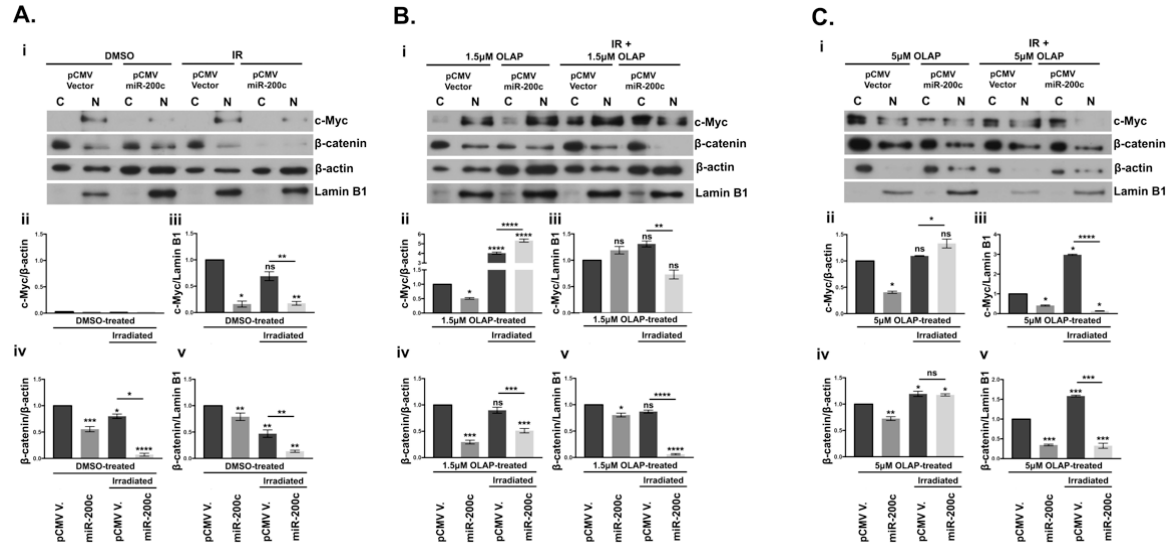
Figure 7. Effects of miR-200c on the distribution of c-Myc and β -catenin expressions in SKOV3 cell line. Cytoplasmic (C) and nuclear fractions (N) were analyzed by WB. β -actin and Lamin B1 are the housekeeping proteins used for cytoplasmic and nuclear extracts, respectively. ( A ) ( i ): empty vector (pCMV V.) and pCMV miR-200c SKOV3 cells treated with DMSO and 4 Gy irradiation (IR). ( B ) ( i ): vector and miR-200c transfected SKOV3 treated with 1.5 µM olaparib-only (OLAP) or in combination with 4 Gy irradiation. ( C ) ( i ): vector and miR-200c transfected SKOV3 treated with 5 µM olaparib-only (OLAP) treated vector and miR-200c or in combination with 4 Gy irradiation. The histograms reported below the WBs represent densitometric analysis by ImageJ of c-Myc and β -catenin, for each treatment. ( ii , iii ): the graphs indicate cytoplasmic and nuclear fractions of c-Myc respectively normalized to β -actin and Lamin B1 ( iv , v ): β -catenin expression in cytoplasmic and nuclear fractions. All the samples were normalized to the vector control SKOV3. The number of pixels from each protein signal imprinted on a film was normalized to the number of pixels of the respective housekeeping gene ( β -actin or Lamin B1), calculated as a ratio. Three WB repetitions were performed with the same lysates and with protein lysates derived from three treatments upon olaparib and irradiation. Dunett’s multiple comparison statistical analysis was carried out with Prism 7 software, between pCMV V. DMSO/1.5µM OLAP/5 µM OLAP/IR-treated and the corresponding treated miR-200c transfected cells. * p < 0.05, ** p < 0.01, *** p < 0.001, **** p < 0.0001, ns: not significant.